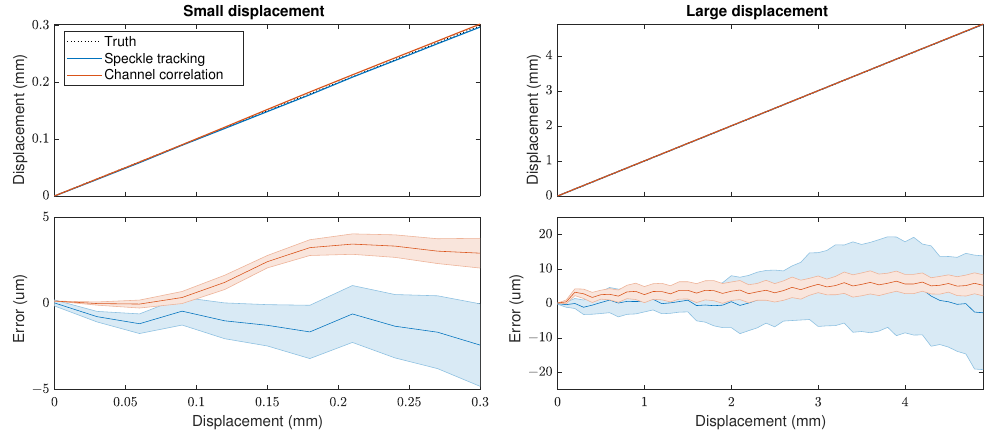
Figure 5. Demonstration of speckle tracking and channel correlation for displacement estimation using individual estimates on pairs of frames. Estimates performed with a 10 × 10 mm kernel. ( Left ) Displacement estimates and error over a short distance, less than one element pitch. Error bars represent 10 speckle realizations. A ± 2.5 mm search region was used. ( Right ) Estimates and error over larger distances, up to 5 mm. A ± 7.5 mm search region was used. Errors depend on the choice of sampling, kernels and subsample estimation method.